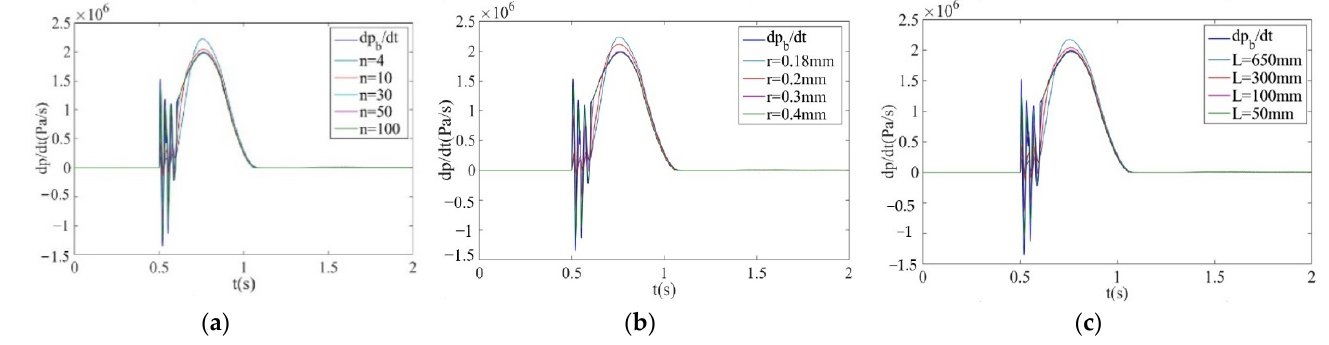
Figure 12. Simulation results of the pressure change rate under different channel numbers, radii and lengths. ( a ) Simulation results of different number of laminar flow channels. ( b ) Simulation results of different laminar flow channel radii. ( c ) Simulation results of different laminar flow channel lengths.